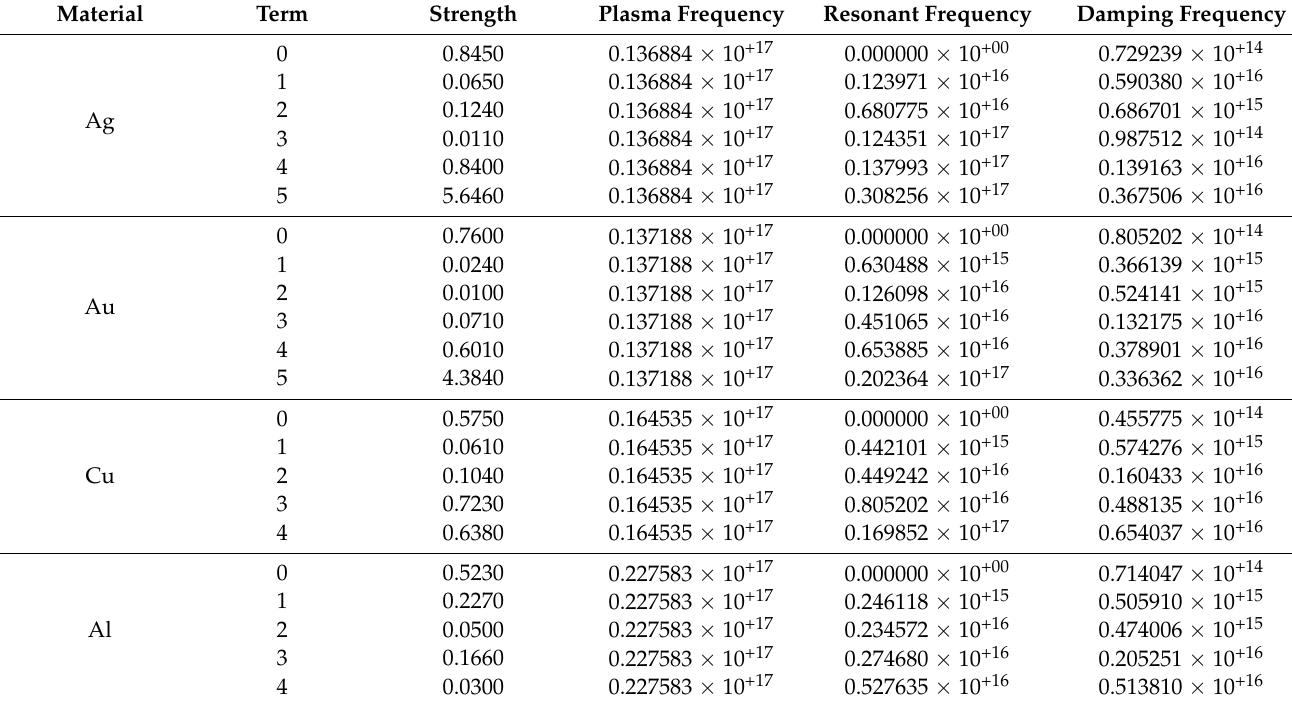
4. Results and Discussion To maximize the absorbed light in the visible and NIR regions, which leads to an increase in the J sc and the overall frequency, different proposals will be produced. The absorption of a traditional SiNW solar cell will be compared to SiNWs coated with a 2D graphene layer and with/without Au plasmonic nanoparticles distributed on the silicon substrate layer. Figure 2a,b illustrates the absorption and transmission of the four pro- posed techniques. As shown in Figure 2a, the absorptions of the traditional SiNWs and of SiNWs coated with graphene are almost the same; however, a high absorption has been obtained when Au NPs are distributed on the top silicon substrate surface. The light trans- mitted through the solar cell is illustrated given in Figure 2b. However, it is very hard to